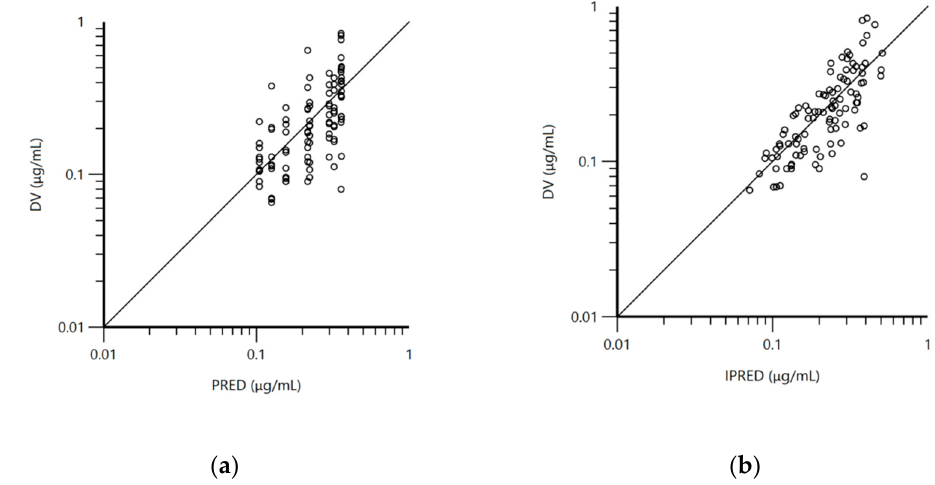
Figure 2. ( a ) Logarithmic plot of the dependent variable (DV, doxycycline concentrations) vs. population predicted doxycycline concentrations (PRED) and ( b ) logarithmic plot of the dependent variable (DV, doxycycline concentrations) vs. individual predicted doxycycline concentrations (IPRED).